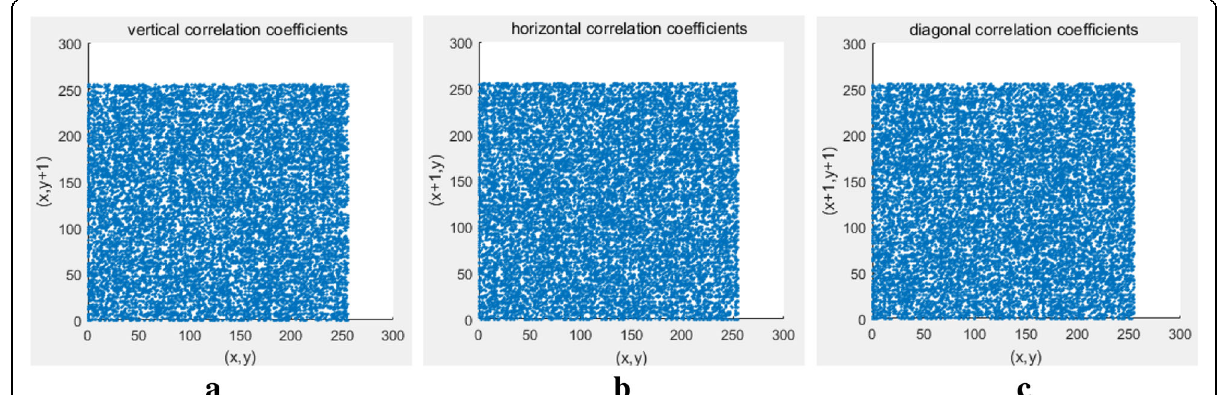
Fig. 11 a Vertical correlations of scrambled and encrypted images. b Horizontal correlations of scrambled and encrypted images. c Diagonal correlations of scrambled and encrypted